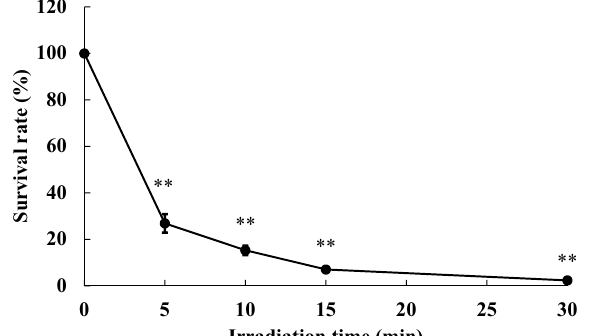
Figure 3. Time-dependent bactericidal effects (viability) of MIR-FEL irradiation at a wavelength of 6.62 µm. Comparisons among groups were performed using one-way ANOVA followed by Tukey’s test. Significant differences are indicated by asterisks (** P < 0.01).